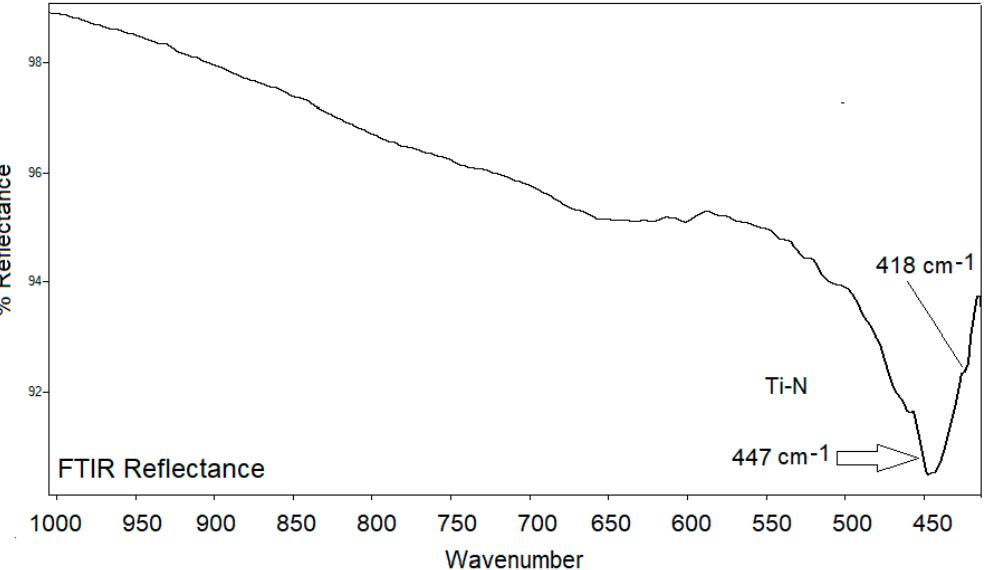
Figure 2. Reflectance infrared spectrum of the TiN sample showing the characteristic Ti–N stretching peaks at 447 cm − 1 and 418 cm − 1 .